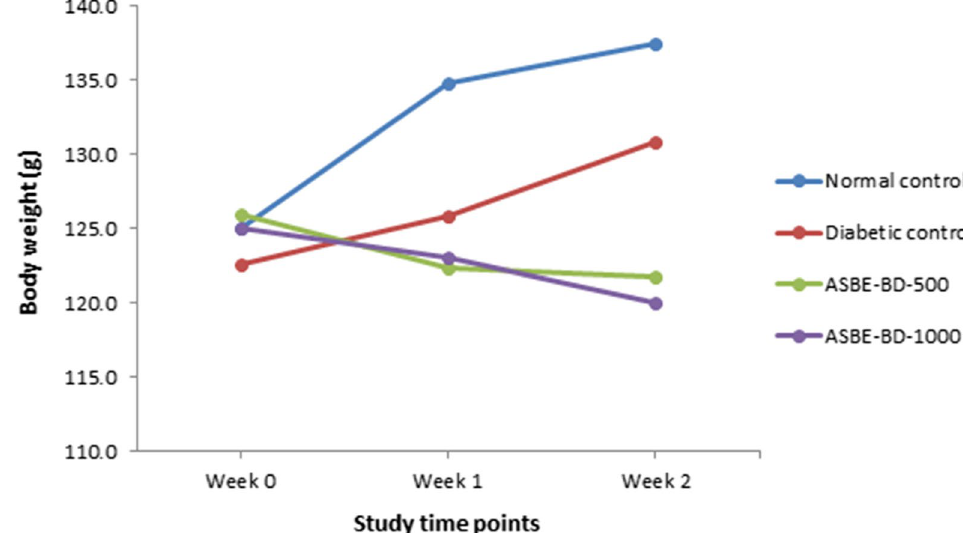
Fig. 1 A profile plot showing groups’ mean scores in body weight at week 0, week 1 and week 2 of the